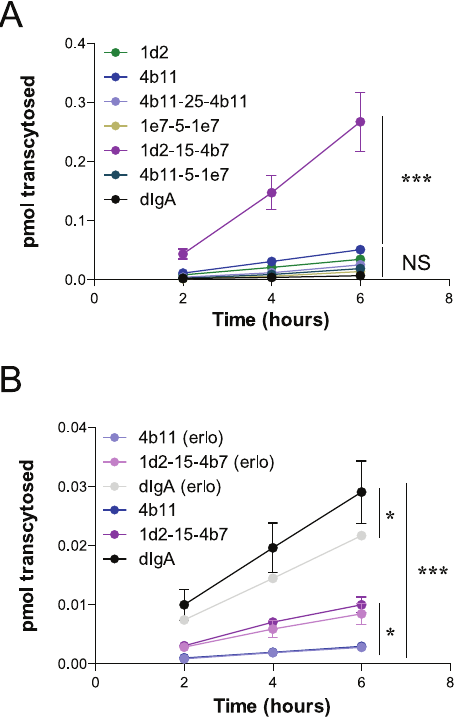
Figure 5. Transcytotic capacity of optimized constructs. (A + B) 1 nM 125 I radio-labelled VHH or dIgA was applied in the basolateral chamber of polarized MDCK-hpIgR cells (A) or Caco-2 cells (B) grown on transwell inserts. Apical medium was resorbed after each 2 h interval to a maximum of 6 h and quantified separately. Amount of pmol that is transcytosed is plotted against time. Leakage of a non-specific VHH control was deducted from the specific signal (n=4) (s.e.m.’s are shown for all points). Significance measurements were done by